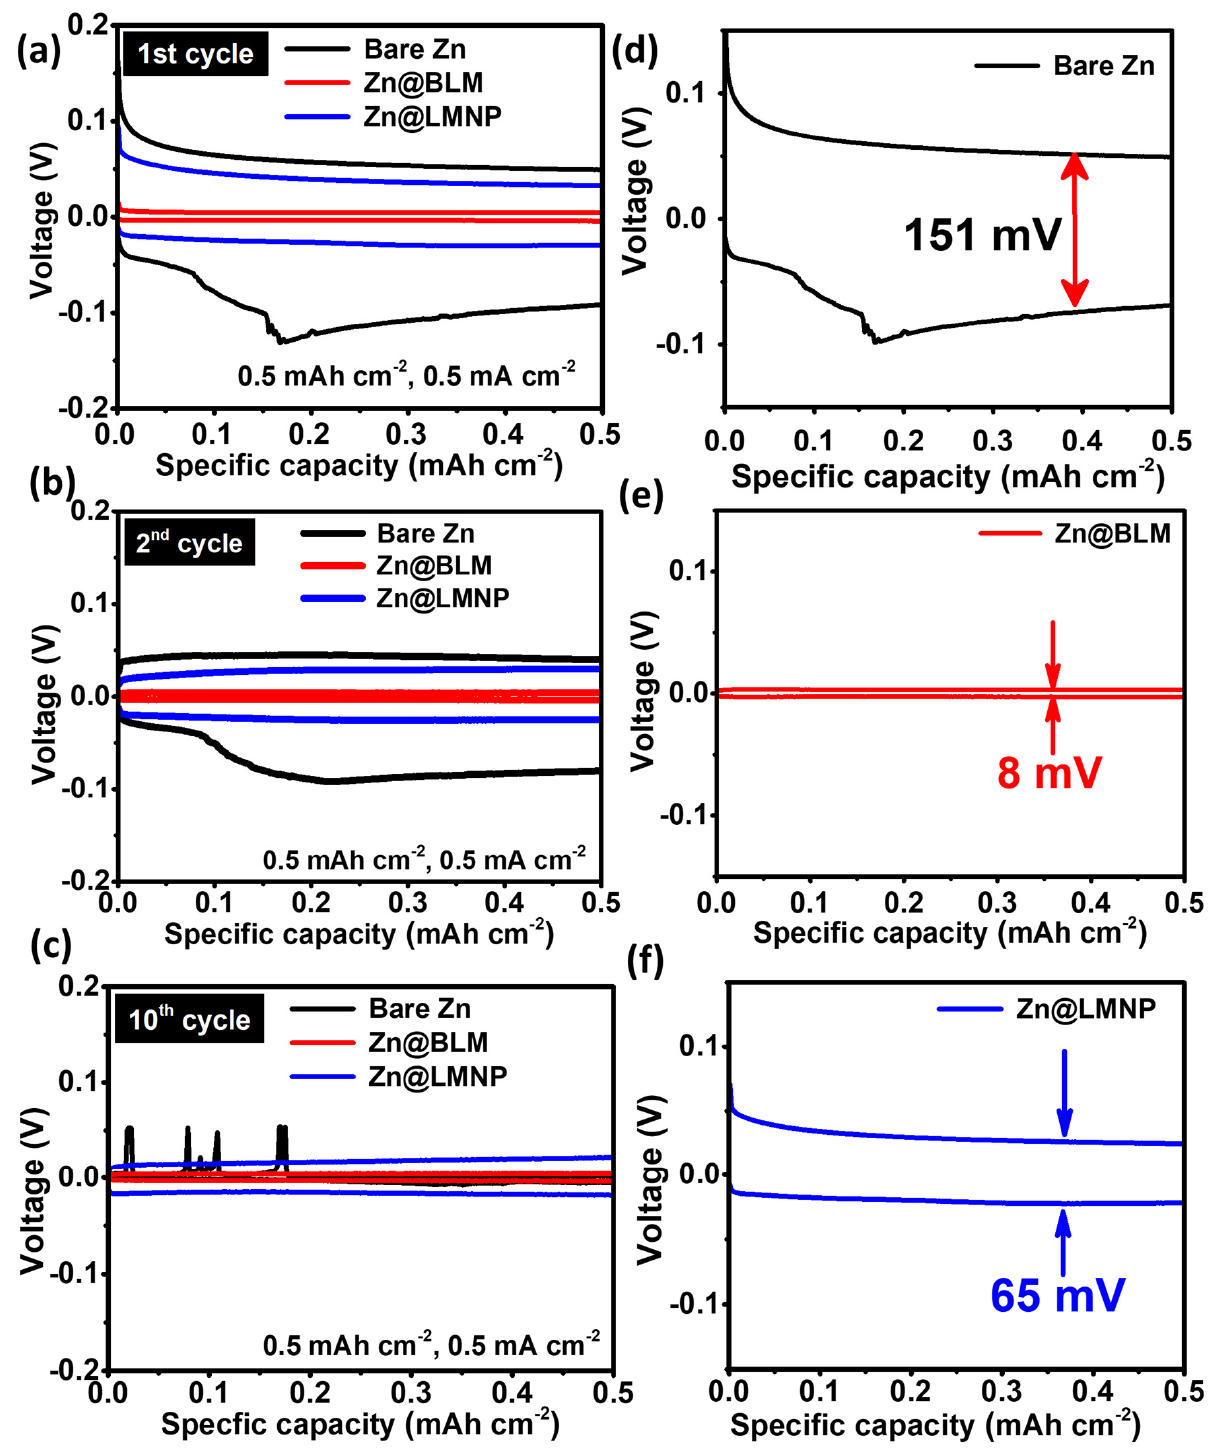
Figure 3. Voltage–specific capacity curves of bare Zn, Zn@BLM, and Zn@LMNP symmetric cells at the typical ( a ) first, ( b ) second, and ( c ) tenth cycles at a capacity of 0.5 mAh cm − 2 and current density of 0.5 mA cm − 2 . Voltage hysteresis (the gap between reversible and irreversible capacity) in the first cycle for the ( d ) bare Zn, ( e ) Zn@BLM, and ( f ) Zn@LMNP electrodes.